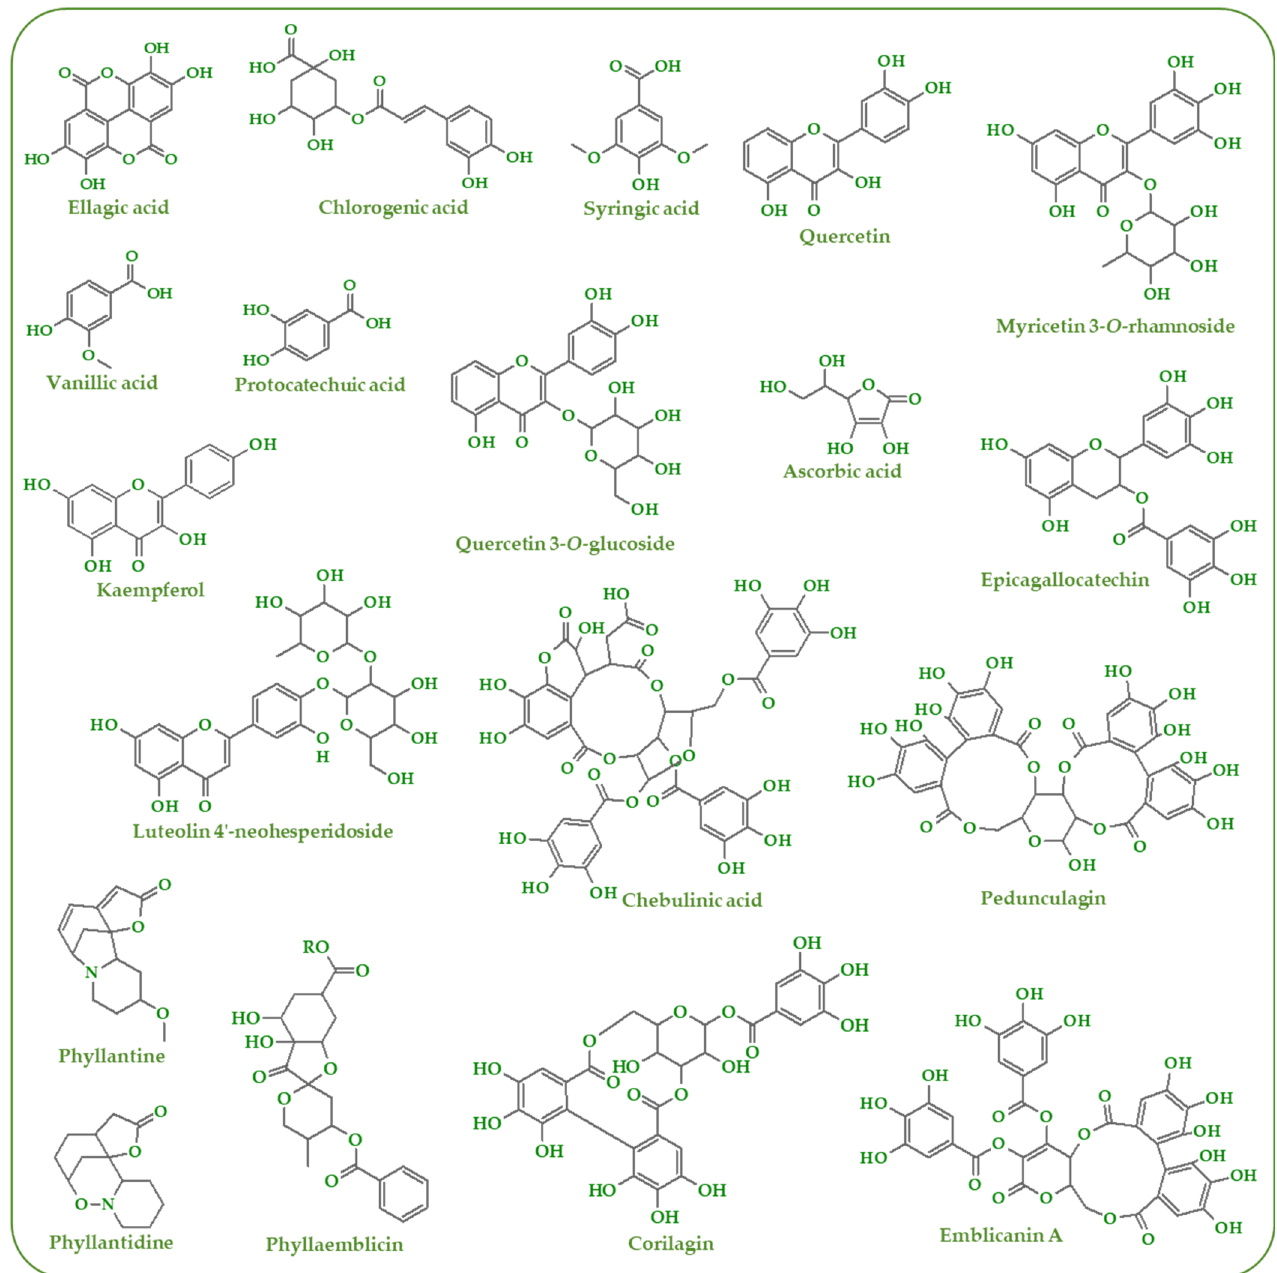
Figure 1. Phytochemicals found in